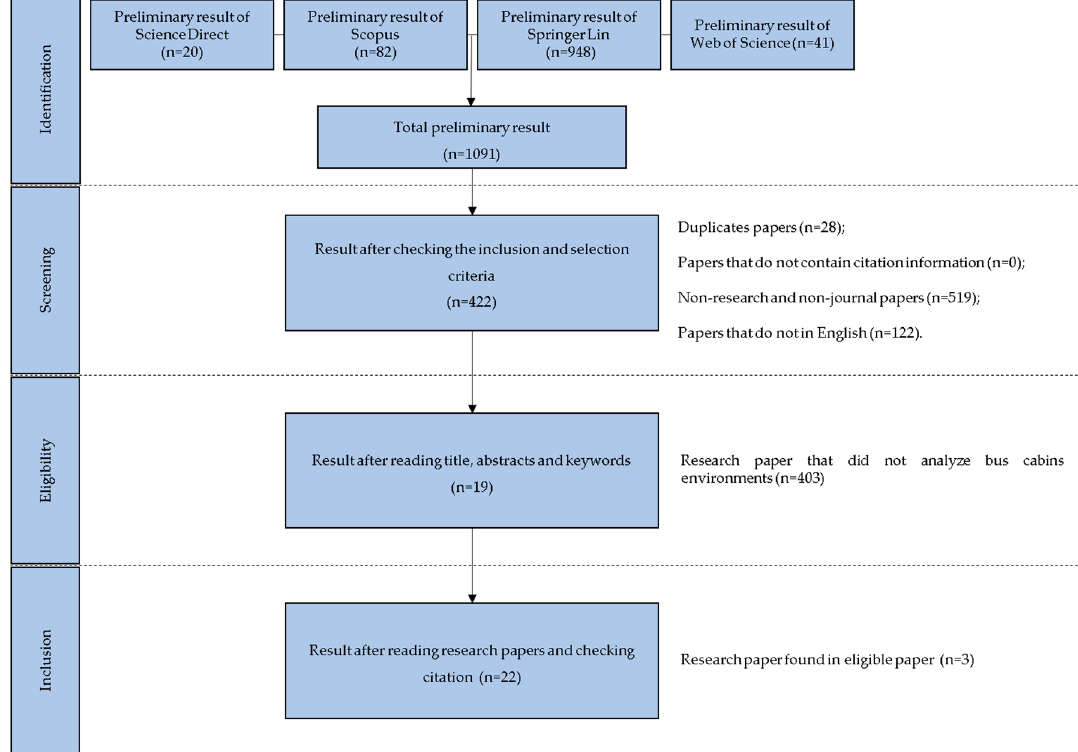
Figure 1. Number of papers on thermal comfort in buses found by this review.